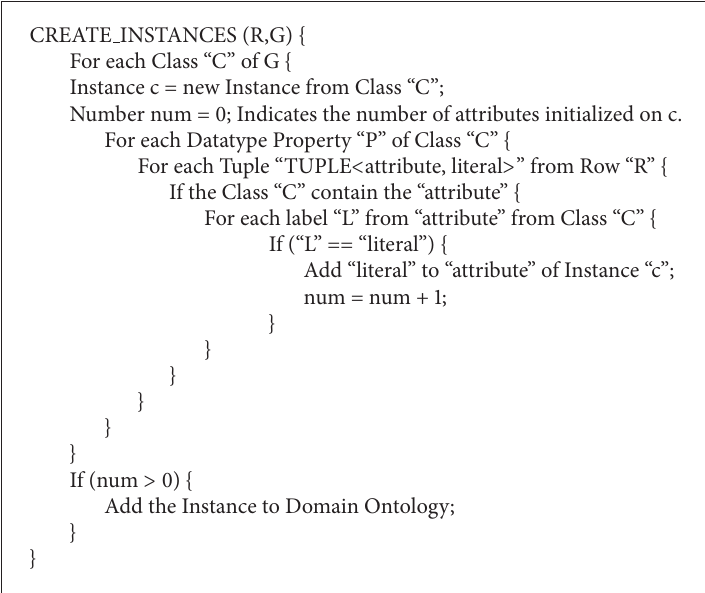
Algorithm 3: Algorithm to create instances of a particular class or group of